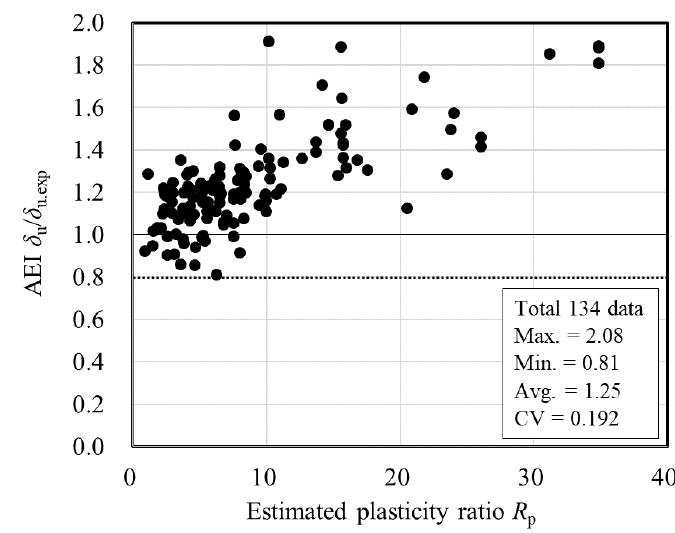
Figure 11. Accuracy of the estimated maximum deflection for the design δ ud ( R p < 40).